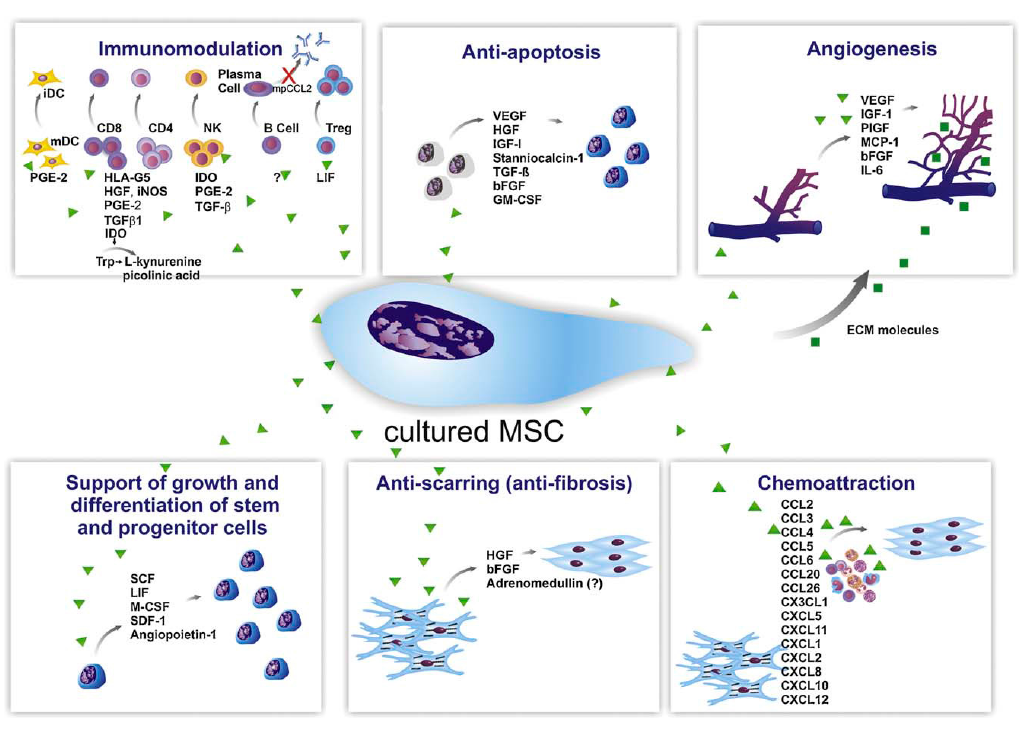
Figure 11. Schematic representation of therapeutic molecules secreted by MSCs to accelerate bone healing. With permission from Reference [374] .